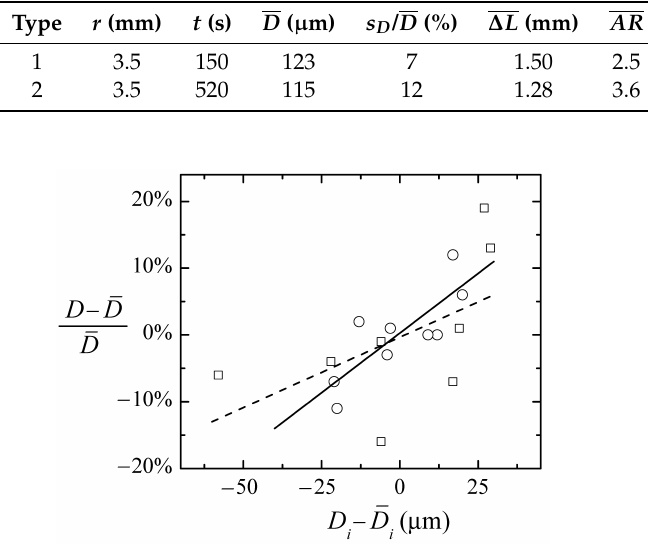
Figure 9. Variability of the neck diameter versus the original capillary inner diameter deviation for thin (circles), and thick (squares) wall capillaries. The solid (dashed) line is the linear fit for the thin (thick)